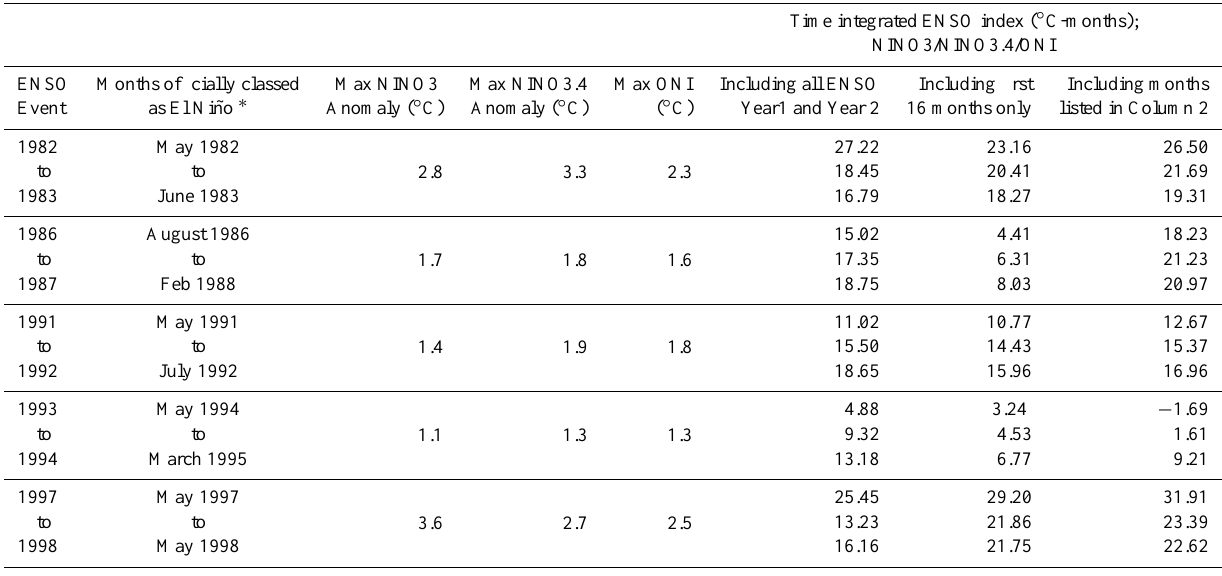
Table 1. ENSO index data for the five El Ni˜no episodes examined herein (1982–1983, 1986–1987, 1991–1992, 1993–1994 and